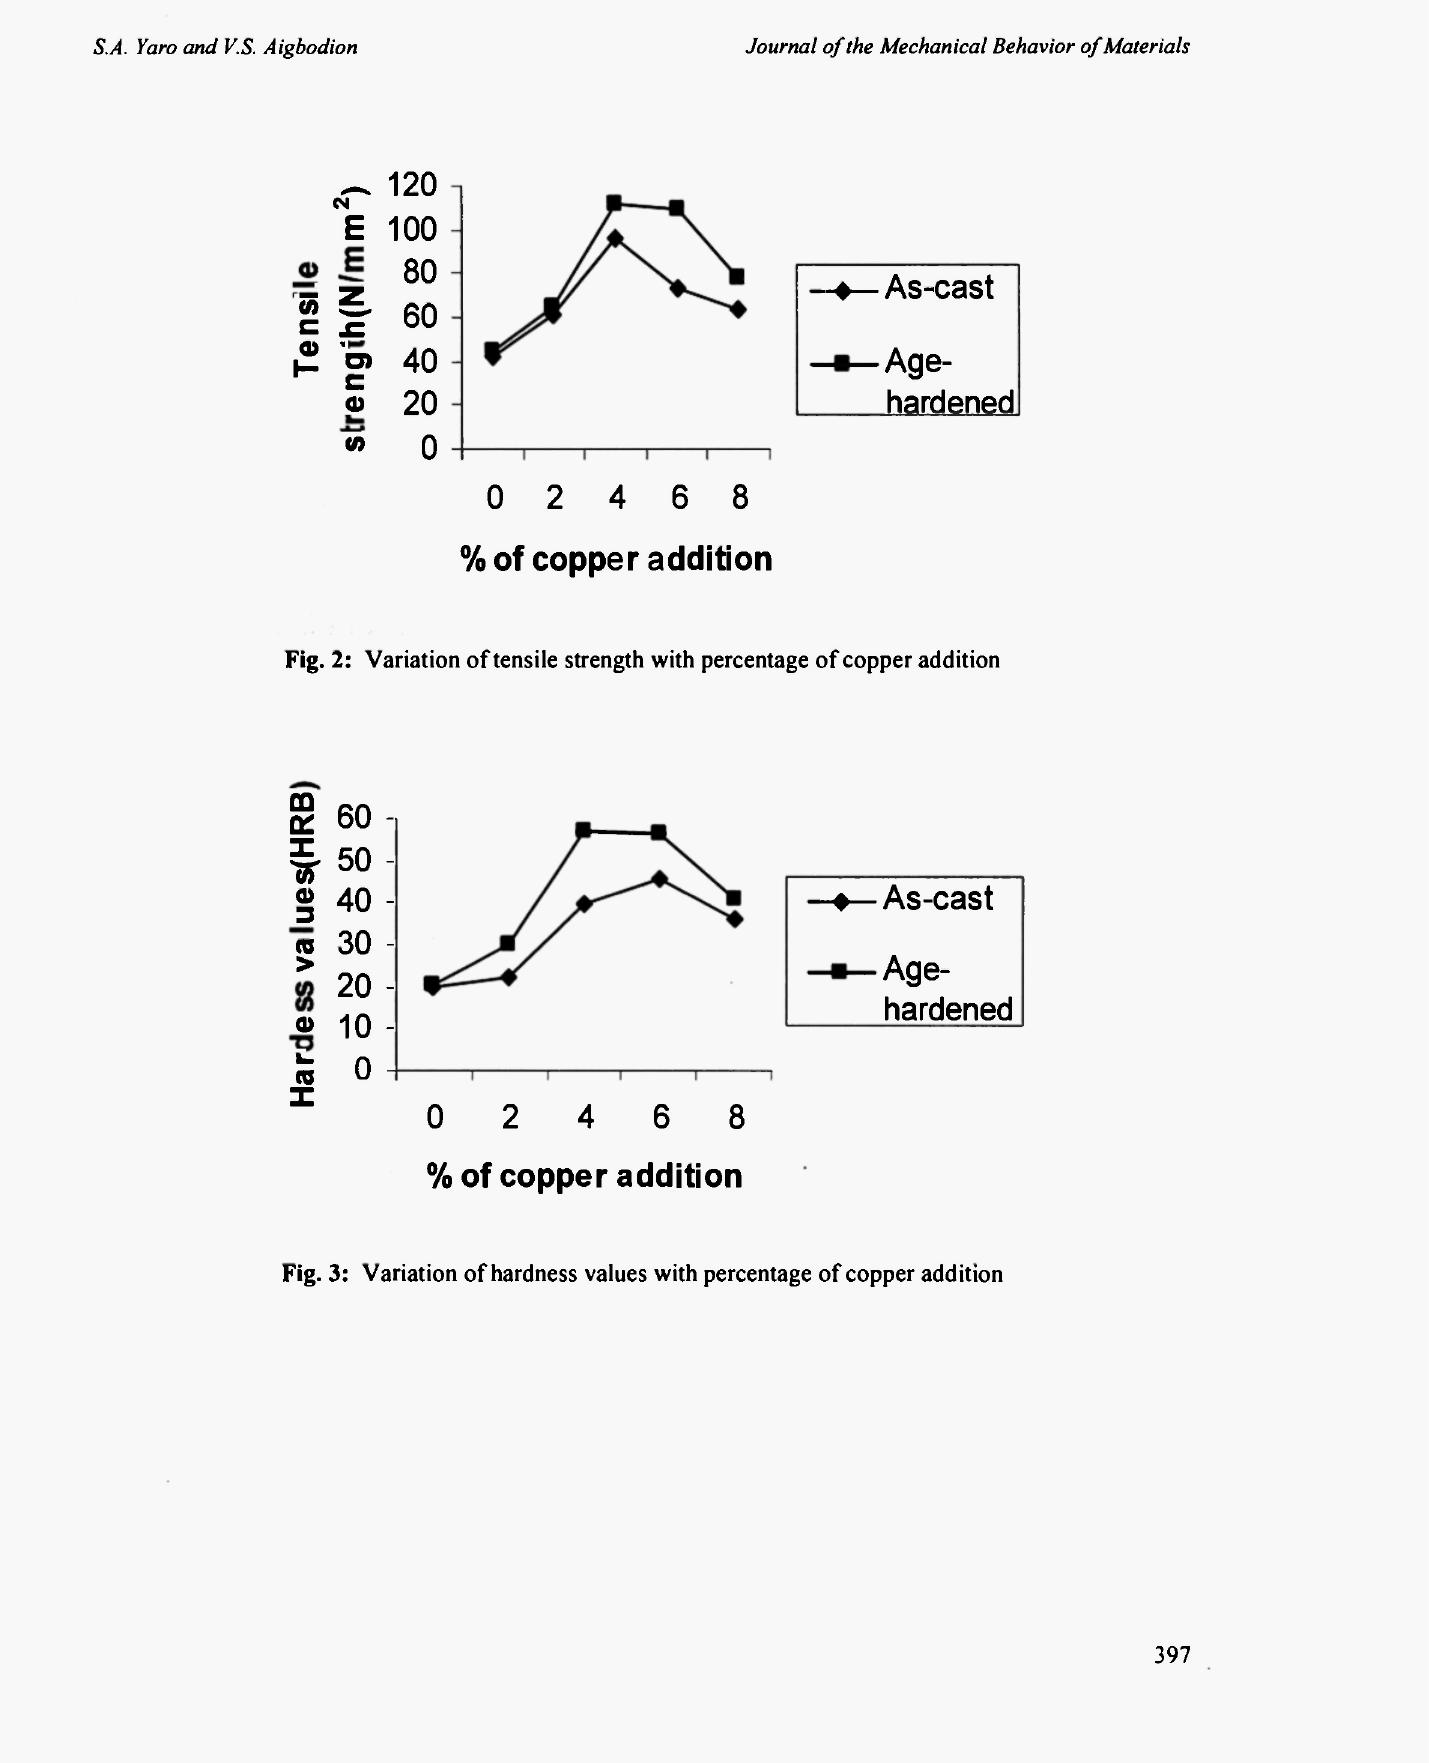
Fig. 3: Variation of hardness values with percentage of copper